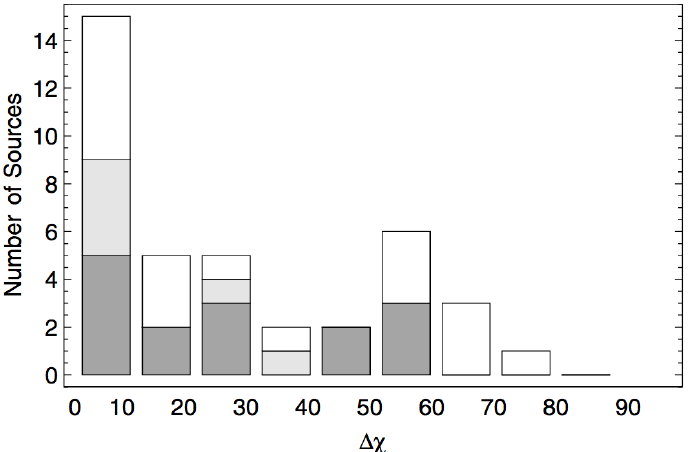
Figure 1. Histogram of the difference between the radio-core and optical polarization angles ∆ χ , including BL Lac objects (white), HPQs (dark grey), and LPQs (light grey). Reprinted with permission from Algaba et al. (2010). Copyright Journal compilation 2010